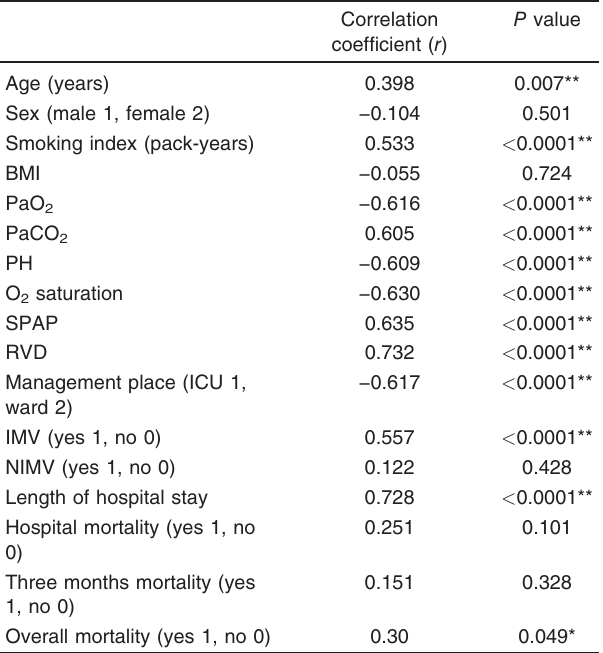
Table 3 Correlations between B-type natriuretic peptide levels and the relevant variables in patients with acute exacerbation of chronic obstructive pulmonary